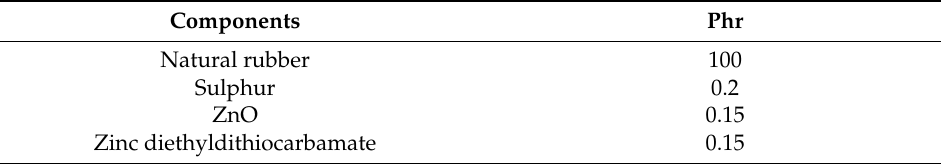
Table 1. Components to be considered when fabricating SME natural